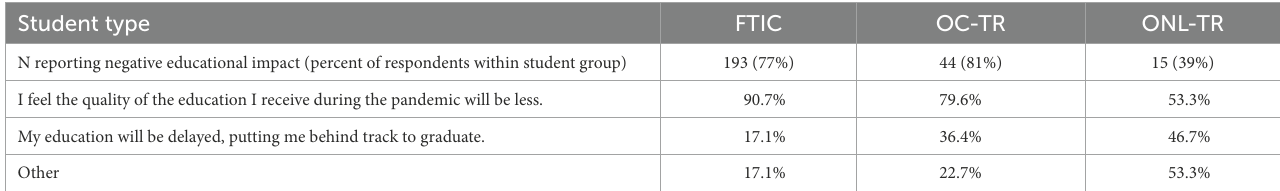
TABLE 2 Percentage of respondents by student type indicating reasons for perceived negative educational impact of the